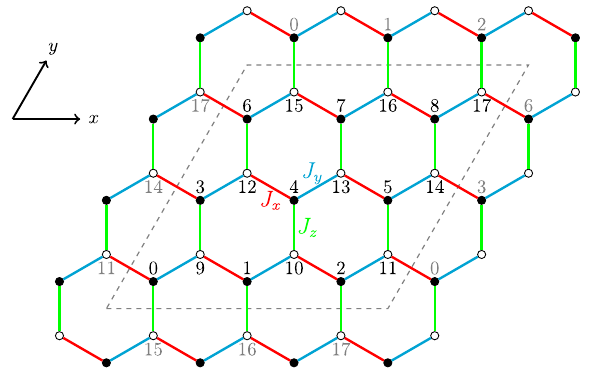
Figure 2. Structure of the Kitaev honeycomb lattice for N = 3 × 3 × 2